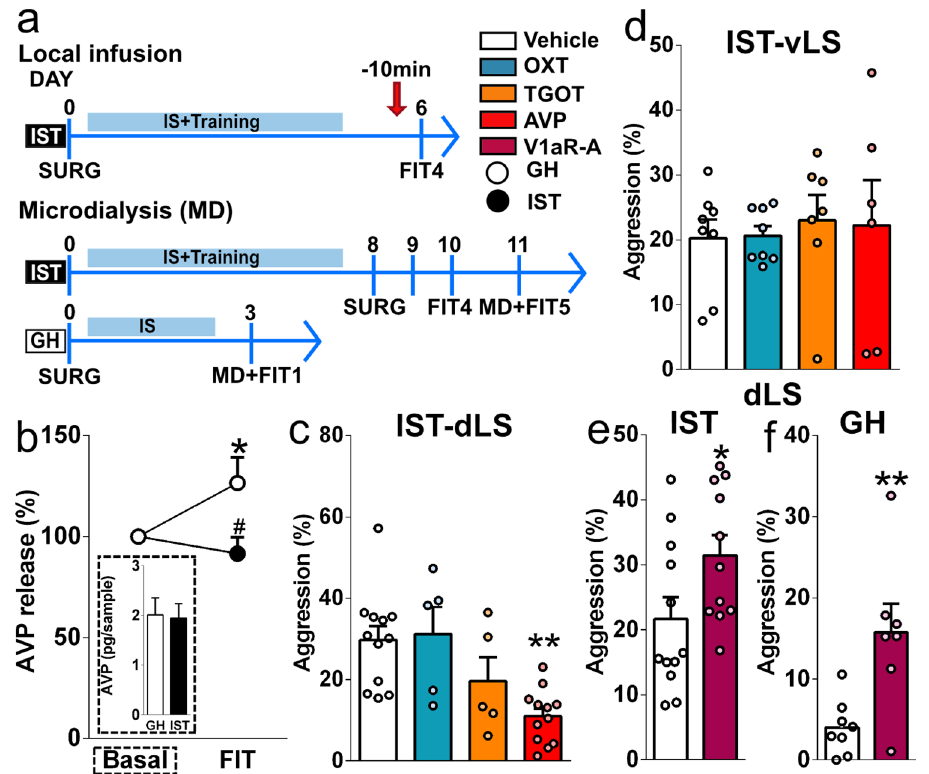
Fig. 5 AVP exerts anti-aggressive effects within the dLS. a Scheme illustrating the experimental design for pharmacology and microdialysis experiments targeting the AVP system ( AVP arginine vasopressin, arrow = drug infusions, FIT female intruder test, GH group-housed, IS social isolation, IST isolated and trained; MD microdialysis, SURG surgery, dLS dorsal part of the lateral septum, OXT oxytocin, TGOT [Thr4,Gly]OXT, OXT receptor agonist, vLS ventral part of the lateral septum; V1aR-A V1aR receptor antagonist). b GH, but not IST females showed an increased rise in the percentage of AVP release (AVP content in microdialysates sampled during the FIT/AVP content in microdialysates sampled in the baseline × 100) in the dLS during the FIT (Wilcoxon signed-rank test GH: W (9) = 45, p = 0.0039; IST: W (7) = − 4.00, p = 0.81), thus AVP release during the FIT was higher in GH than in IST rats (Mann – Whitney U test = 6.00, p = 0.0052). Insert shows that absolute AVP content in microdialysates sampled under basal conditions did not differ between the groups. c Infusion of AVP, but not OXT or TGOT (all at 0.1 ng/0.5 µ l), into the dLS decreased total aggression in IST females ( F (3,30) = 7.292, p = 0.0008). d AVP infusion into the vLS did not change aggression in IST females ( F = 0.11, p = 0.95). Local blockade of V1aR (100 ng/0.5 µ l) prior (3,25) to the FIT increased aggression in e GH (two-tailed Student ’ s t test t (13) = 3.31, p = 0.006) and f IST rats ( t (20) = 2.14, p = 0.045). Data are shown as mean + SEM. # p < 0.05 vs GH; * p < 0.05, ** p < 0.01 vs either vehicle or baseline. Microdialysis: n = 8 and 9; AVP, OXT, TGOT dLS: 12, 5, 5 and 12, respectively; vLS: 8, 8,7 and 6, respectively; V1aR-A: GH: n = 8 and 7, IST: n = 12 and (Fig. 6i). Apart from the speci fi c expression of V1aRs and OXTRs, dorsal and vLS neurons also differed regarding the expression of other markers: somatostatin-positive cell bodies were only found in the dLS (Fig. 6g), whereas estrogen receptor α (ER α ) expressing cells were exclusively located in the vLS (Fig. 6h), further reinforcing that vLS and the dLS neurons are distinct populations.